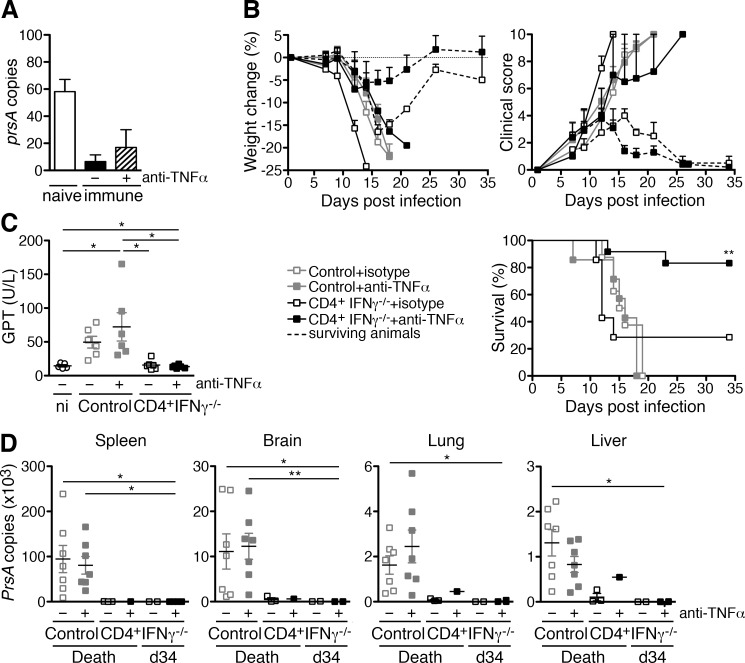
Enhanced protection by CD4+IFNγ-/- T cells in the absence of TNFα.1×106 bone-marrow-derived BALB/c macrophages were infected with 5 copies of R. typhi per cell one day prior to the addition of 2×106 purified CD4+ T cells from either naïve or immune BALB/c IFNγ-/- mice (day 7 post infection). TNFα was neutralized by simultaneous addition of 10 μg/ml anti-TNFα. Bacterial content in the cultures (y-axis) was assessed by prsA-specific qPCR 72h after T cell addition. Graphs show the mean and SEM of combined results from two independent experiments (n = 4 T cells from each group of mice) (A). CB17 SCID mice (n = 7 for each group) were infected with 1×106 sfu R. typhi. 1×106 purified CD4+ T cells from BALB/c IFNγ-/- mice were adoptively transferred one day prior to the infection with R. typhi. Control groups of mice received PBS instead. TNFα was neutralized by intraperitoneal application of 500 μg anti-TNFα every three days beginning on day 3 post infection. Control animals received equal amounts of isotype antibody. The state of health of the mice was monitored by weight change (y-axis, upper left) and a clinical score (y-axis, upper right) and the survival rates (y-axis, below) were assessed. Dotted lines show the data for surviving animals of the isotype- and anti-TNFα-treated groups of CD4+IFNγ-/- recipients. Statistical analysis of survival rates was performed with Log-rank (Mantel-Cox) test. Asterisks indicate significant differences compared to control animals (**p<0.01) (B). Serum GPT levels (y-axis) were assessed from all groups of animals at the time of death and in surviving animals at the end of the experiment (day 34). Combined results are shown. Each dot represents a single mouse. Statistical analysis was performed by One-way ANOVA (Kruskal Wallis test followed by Dunn´s post test) (*p<0.05) (C). The bacterial content (y-axis) in the organs was quantified by prsA-specific qPCR from all animals that succumbed to the infection at the time of death and from surviving animals at the end of the experiment (day 34) as indicated on the x-axis (D). Statistical analysis for C and D was performed by One-way ANOVA (Kruskal-Wallis test followed by Dunn´s post test). Asterisks indicate statistically significant differences (*p<0.05, **p<0.01).